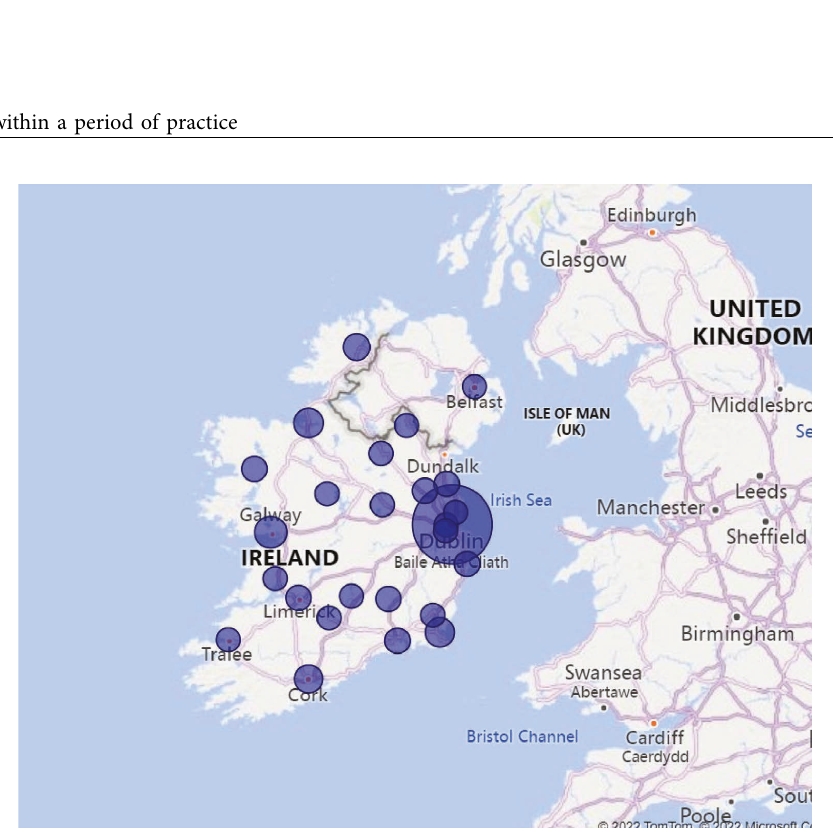
Figure 1: A heat map of where participants were working across the country. A heat map of survey participants. Table 2: Reported MS-relevant post-registration training com- pleted by healthcare professionals ∗ .